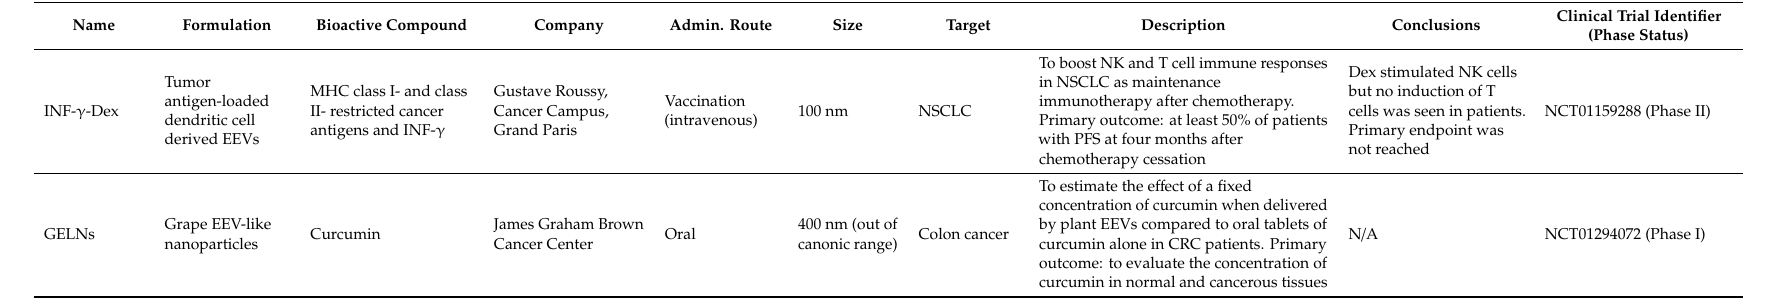
Table 7. EEV clinical trials for new cancer